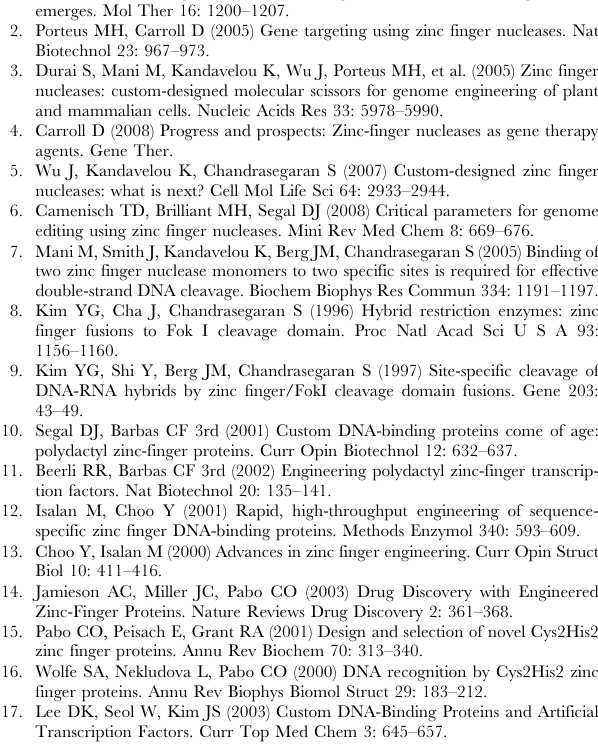
Table S26 Sequences of primers used in this